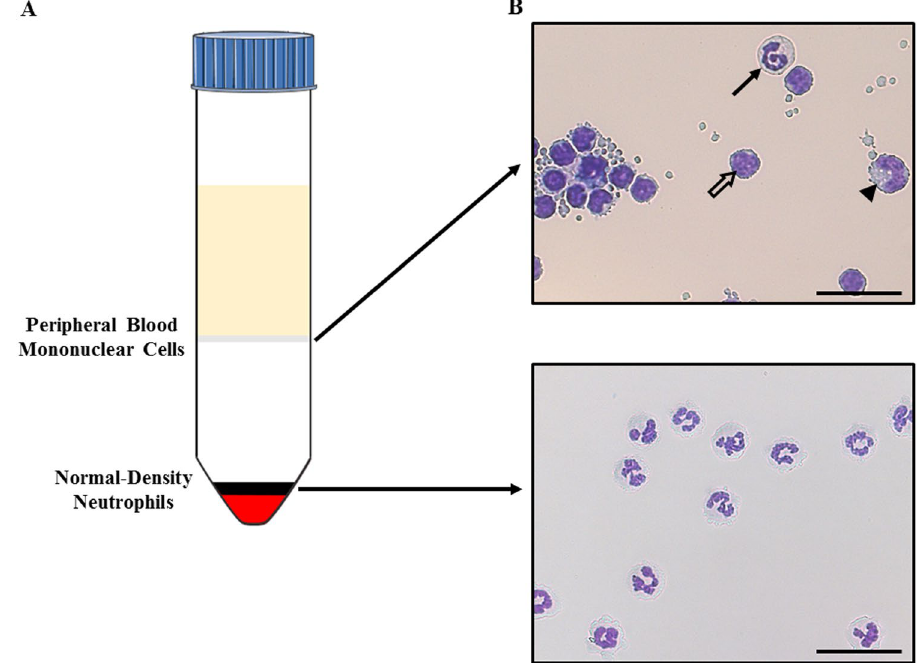
Figure 8. Isolation procedure for the neutrophil subsets from equine blood. ( A ) Ficoll density gradient separating Low-Density Neutrophils (migrating at the interface blood/gradient together with peripheral mononuclear cells) from Normal-Density Neutrophils migrating at the bottom of the gradient together with red blood cells. ( B ) Neutrophil subsets morphology evaluated by optical microscopy at 400 × magnification (scale bar = 28 µ m). Upper panel: LDNs (full arrow) with mononuclear cells (lymphocytes indicated by the empty arrow and monocytes indicated by the arrowhead). Lower panel: NDNs after erythrolysis by a hypotonic treatment. Neutrophil subsets were cytocentrifuged and stained with Protocol Hema 3 and imaged using the NanoZoomer 2.0-HT